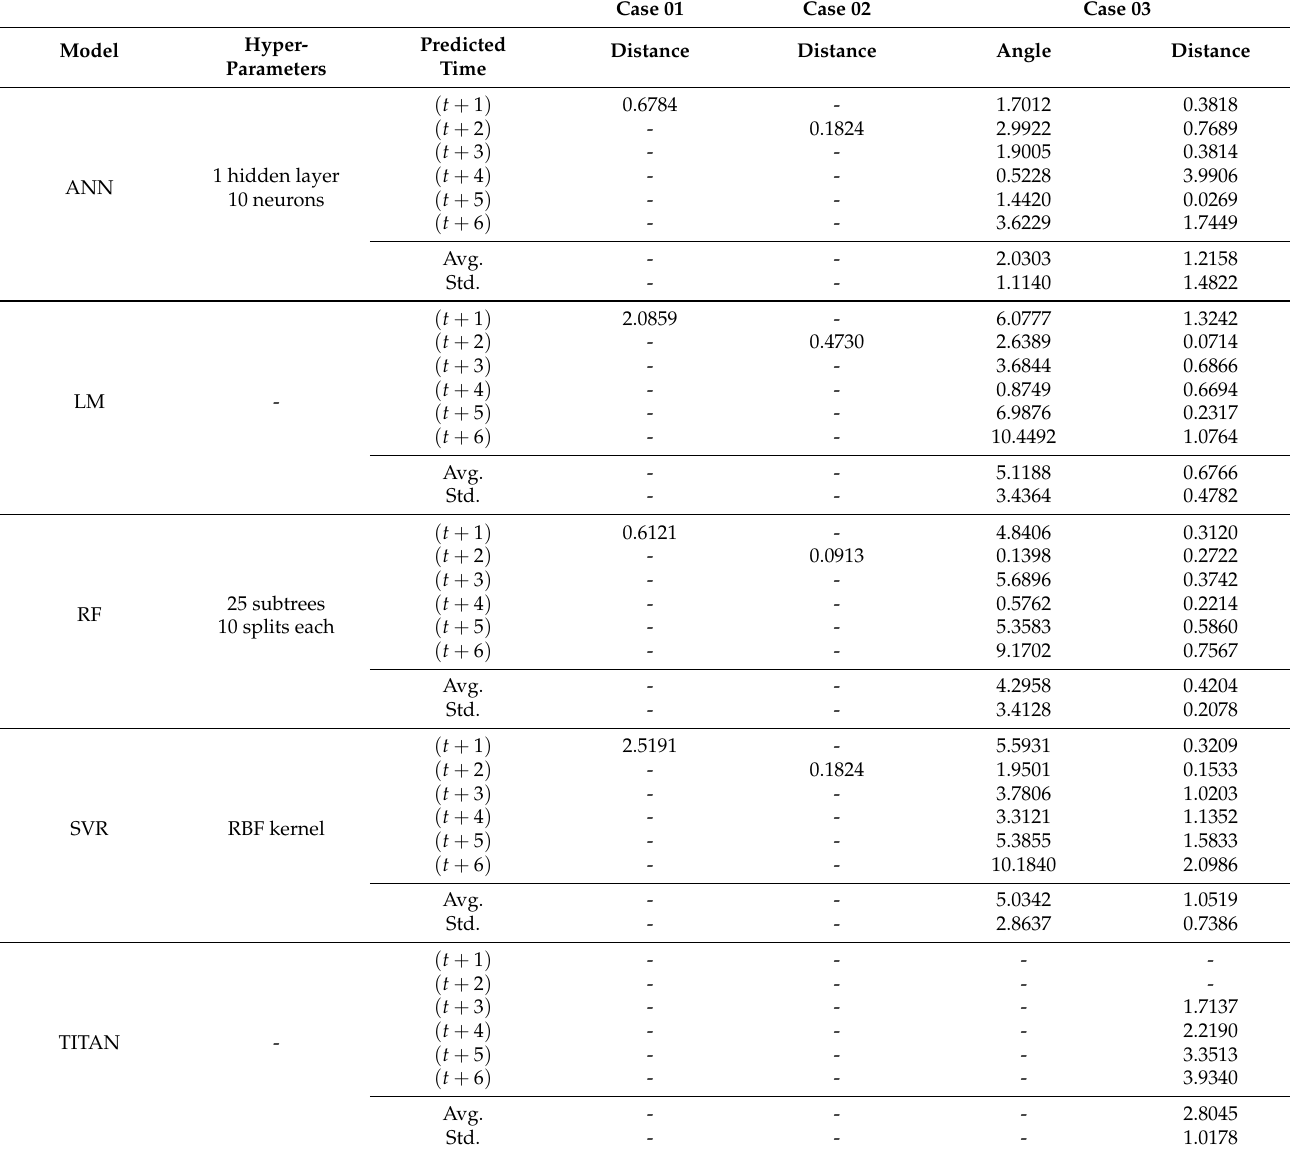
Table 3. Performance evaluations using root mean squared error (RMSE) for location prediction